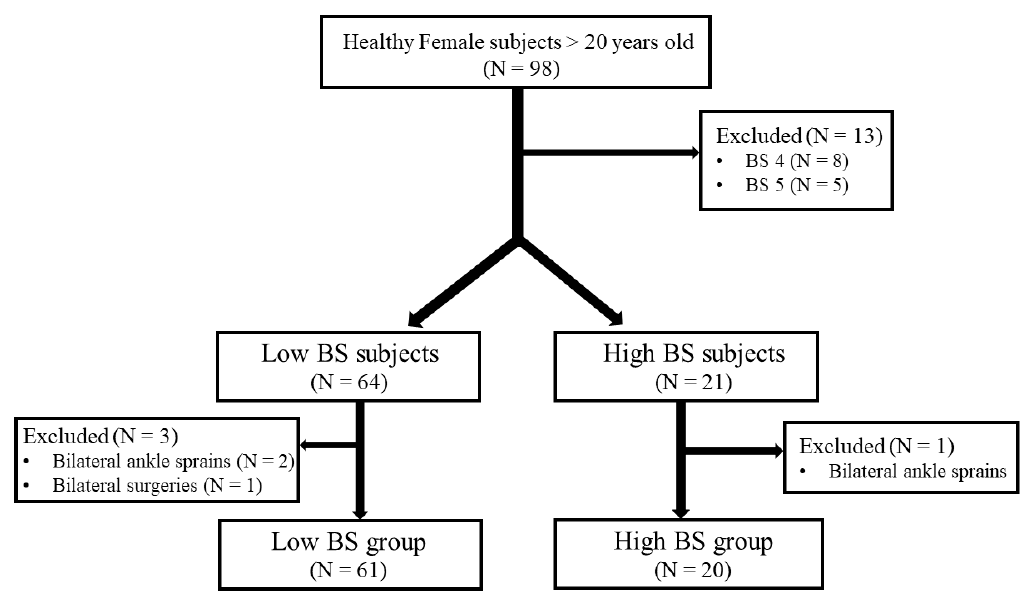
Figure 1. Flowchart of participant enrollment.